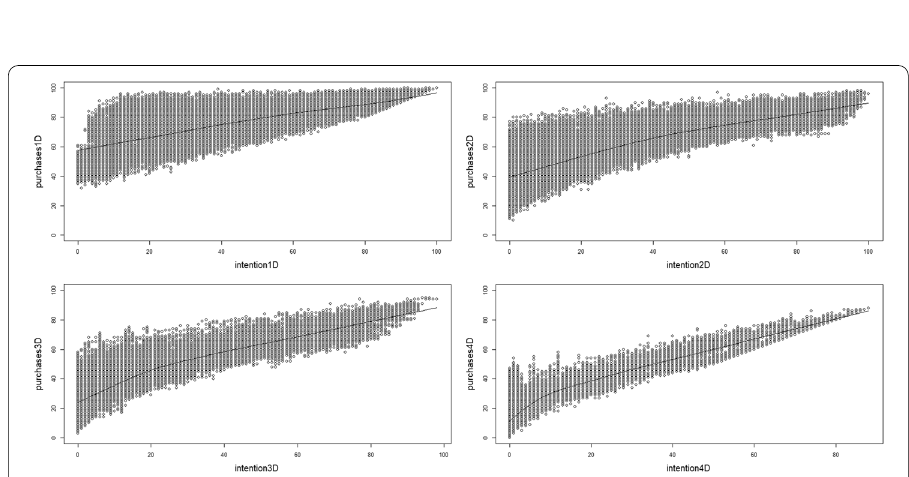
Fig. 3 Scattered plots showing the level of A i and B i for 1, 2, 3 and 4 dimensions of characteristics. Steeper curves observed for higher values of n d (baseline and modified values